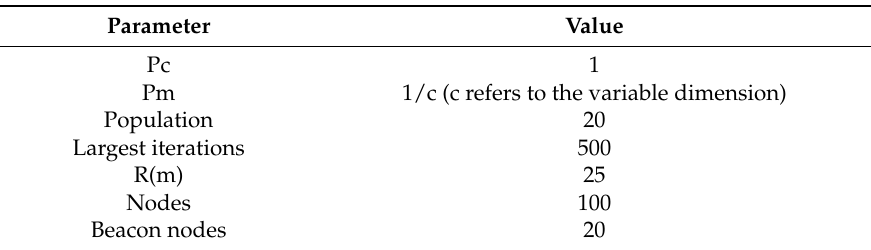
Figure 7. Four different complex networks topologies. ( a ) The random topology; ( b ) The C-shaped random topology; ( c ) The O-shaped random topology; ( d ) The X-shaped random topology. Table 1. Parameter